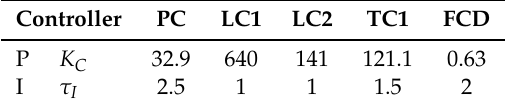
Table 5. Proportional-integral (PI) controllers gains for single temperature control.